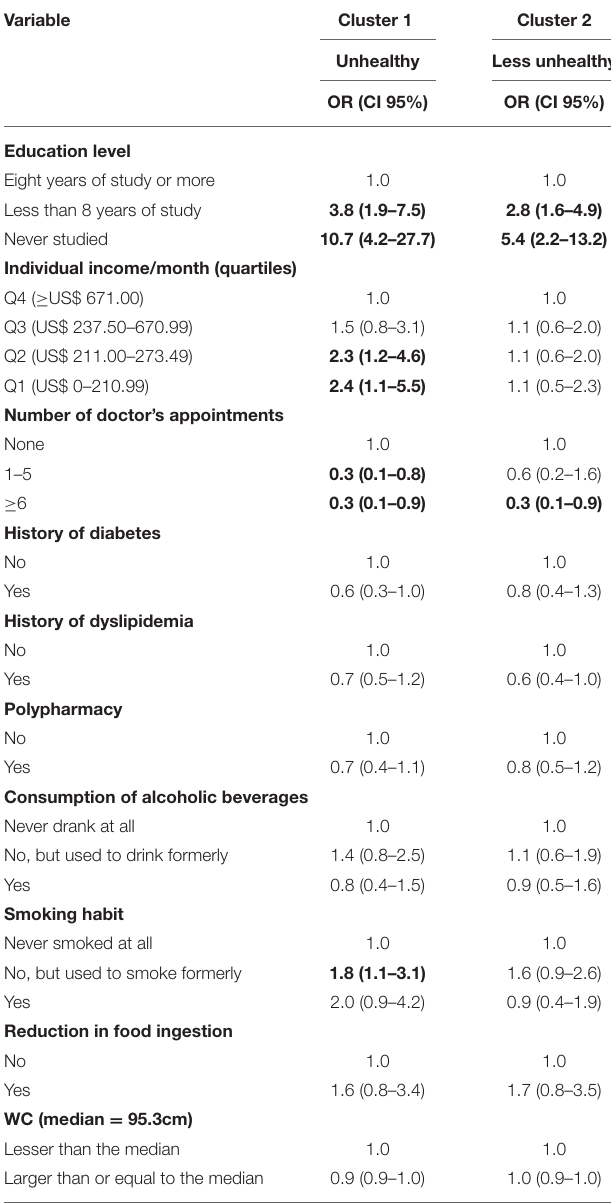
TABLE 4 | Final results of the multiple analysis of the association among the sociodemographic and health conditions and the food consumption clusters a , Viçosa, State of Minas Gerais, Brazil, 2009 ( n =